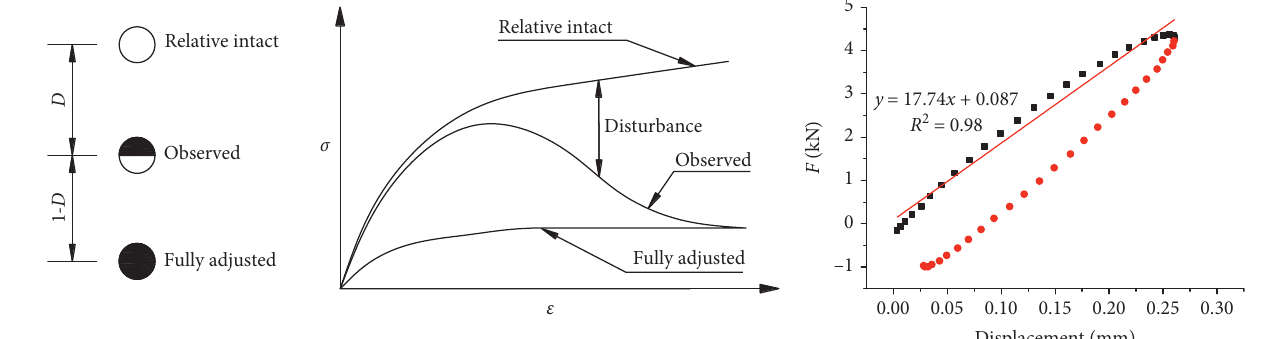
Figure 3: Schematic of the stress-strain behavior in the DSC and definition of the initial